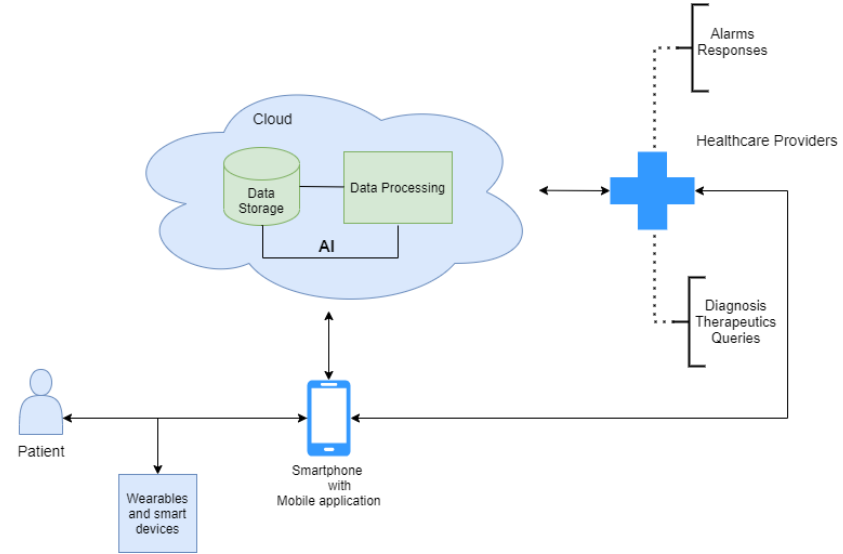
Figure 2. Architecture of the proposed system.